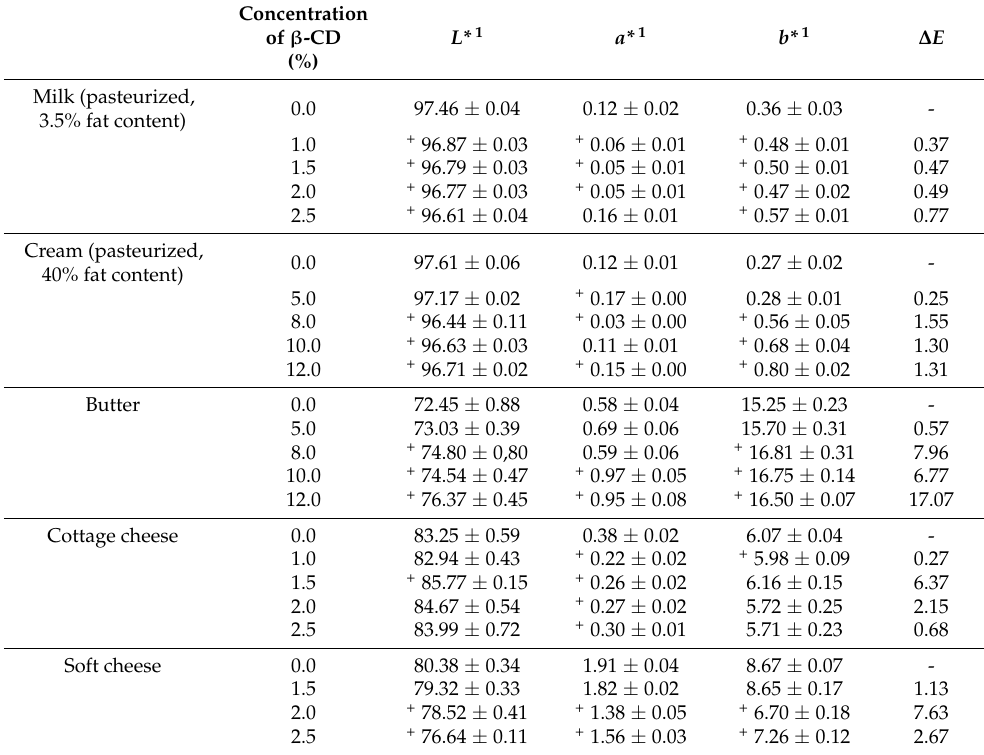
Table 2. The effect of the concentration of β -CD on the color characteristics of dairy products. Color coordinates are expressed as L* (lightness factor), a* ( − a * = green, + a * = red), b* ( − b * = blue, + b * = yellow) and ∆ E (color differences).